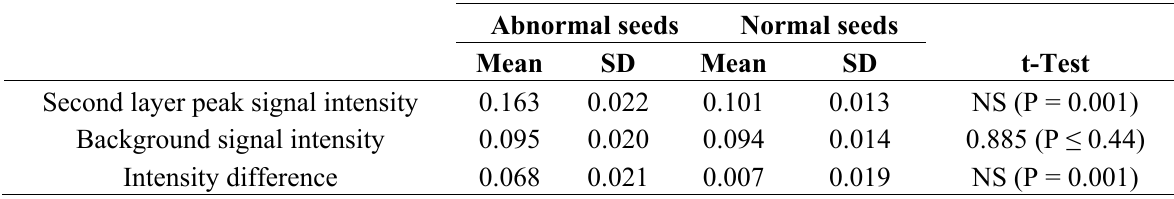
Table 1. Descriptive statics for OCT A-scan signal intensity measurement of second layer peak signal intensity, background signal intensity, Intensity difference between second layer peak and background signal for the abnormal and the normal seed [n = 20 (abnormal), 20 (normal); NS not significant; Unit: dB].